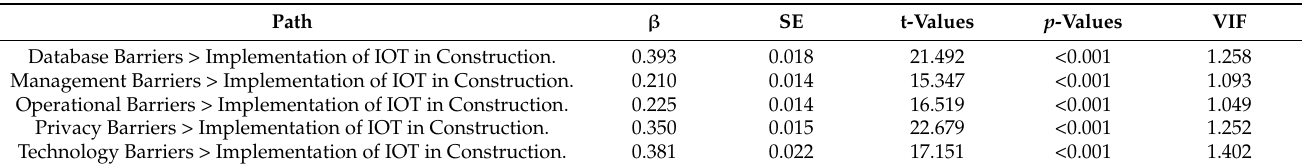
Table 9. Path details of all constructs on the implementation of IOT in small construction linebreak project